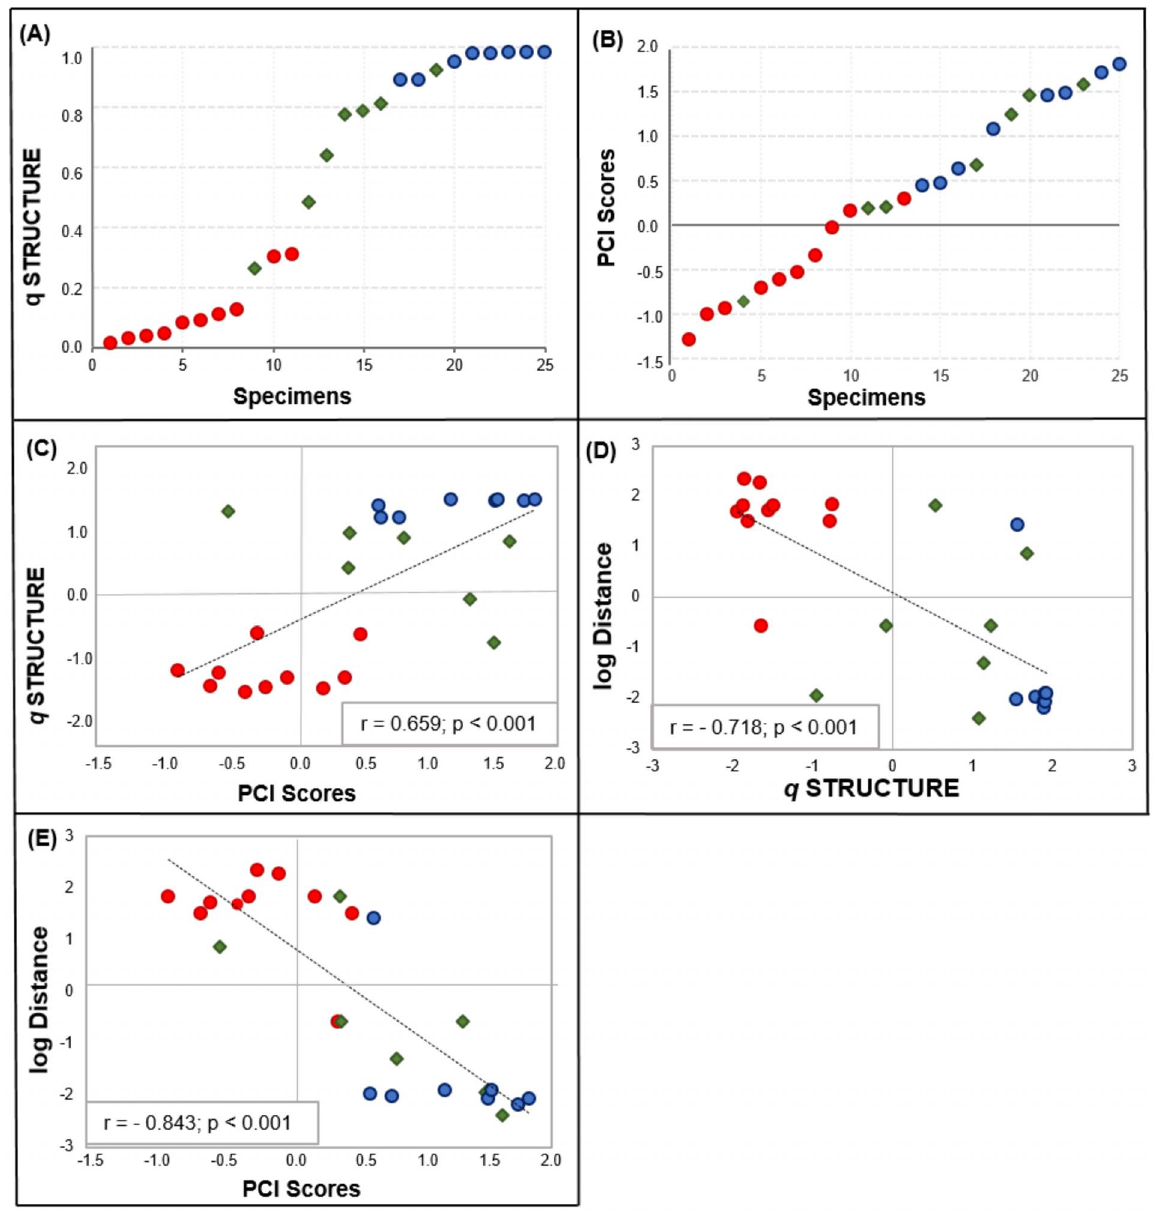
Figure 6. Correlation of morphological, genetic and spatial variables among the male specimens sampled in RS and vicinities. (A–B) patterns of genetic (A) and morphological (B) variation, with individuals ordered on the X-axis based on their ‘ q ’ values estimated with STRUCTURE (in A) or their PCI scores estimated with the PCA (in B); (C) correlation between genetic and morphological variation; (D–E) correlation between individual ‘ q ’ values (D) or PCI scores (E) and spatial transects across the hybrid zone. Geographical distances used in the spatial analyses were measured in km as lines that were perpendicular to the dashed line shown in Figure 4, with samples collected north or east of this line (towards the L. guttulus side) receiving a positive value, and those obtained south or west (towards the L. geoffroyi side) receiving a negative value - see Methods for more details. Red circles = individuals identified as pure L. guttulus ; blue circles = individuals identified as pure L. geoffroyi ; green diamonds = hybrids. PCA scores and the STRUCTURE coefficient of membership q were standardized to a scale from 2 2 to + 2, while geographic distances were